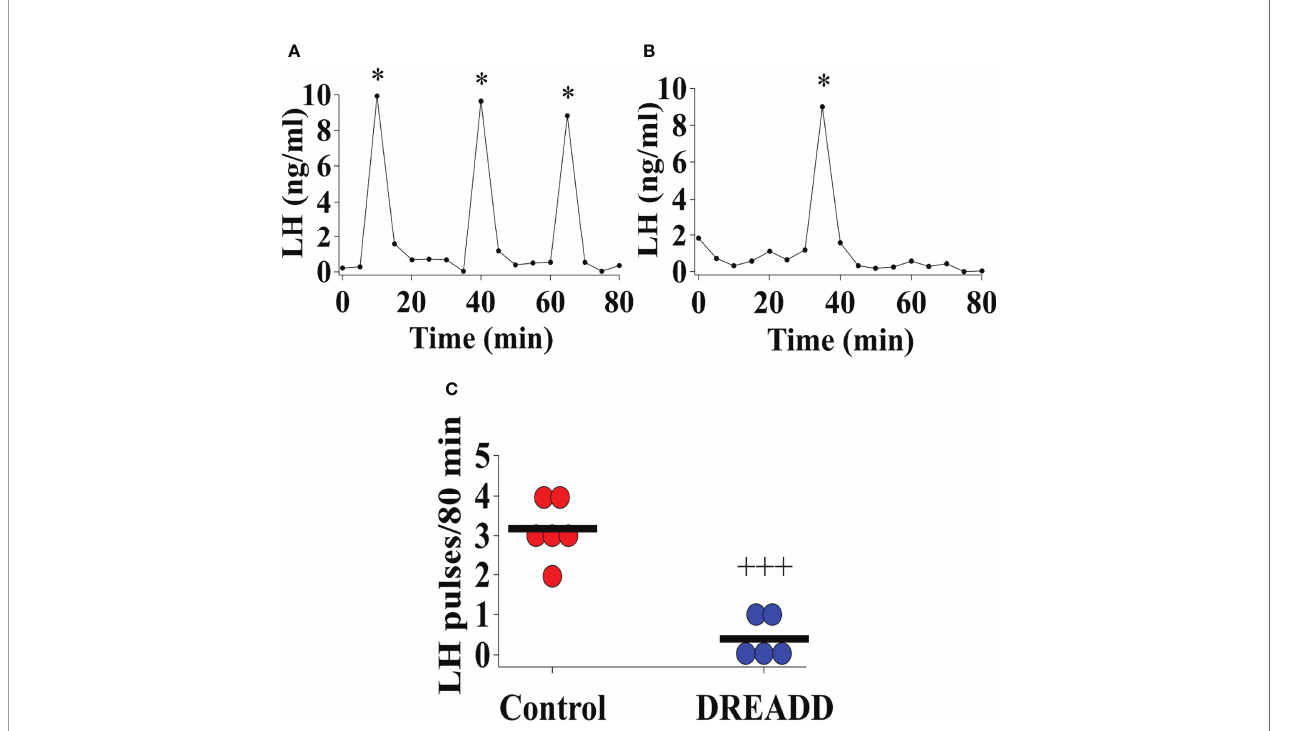
FIGURE 8 | DREADD (hM3D) activation of urocortin 3 (Ucn3) neurons in the posterodorsal sub-nucleus of the medial amygdala (MePD) in Ucn3-cre-tdTomato female mice from post-natal day (pnd) 21 for 14 days suppressed pre-pubertal LH pulse frequency sampled on pnd 29. Representative LH pulse pro fi le in Ucn3-cre-tdTomato female mice on pnd 29 with (A) control mouse, (B) DREADD (hM3D) activated mouse, (C) Summary of LH pulse frequency on pnd 29 of control and DREADD group during the 80 min blood sampling period. LH pulses detected by the DynePeak algorithm are indicated with an asterisk * located above each pulse on the representative LH pulse pro fi les. F (1,9) =46.58, +++p<0.0001 of control group (combined control AAV: n=3; cre-negative control: n=3) vs DREADD group